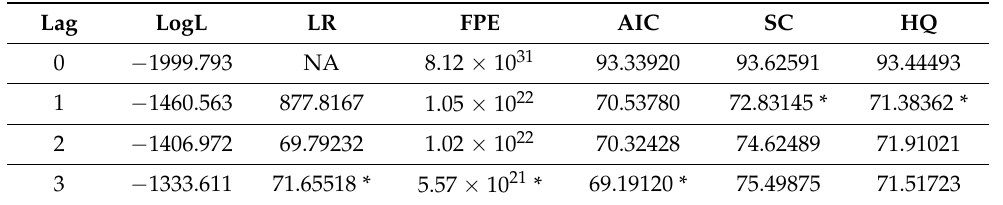
Table 6. VAR lag length selection